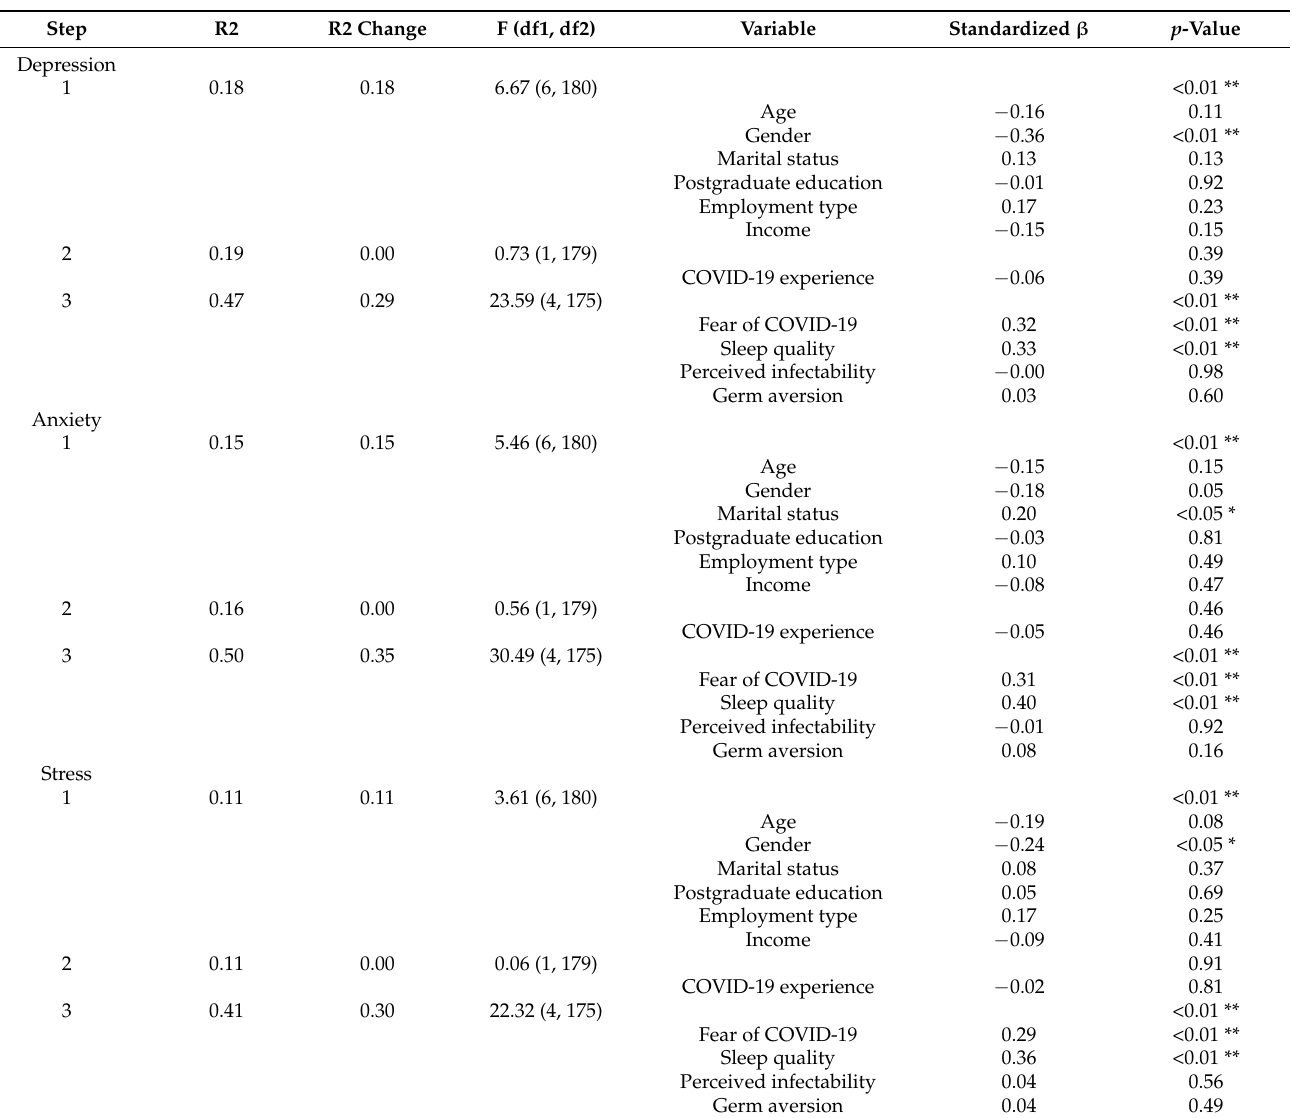
Table 4. Multiple linear regression. Results are shown separately for depression, anxiety, and stress as outcome variables. The demographic variables were entered as Block 1, experience with COVID-19 as Block 2, and independent variables as Block